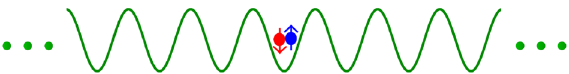
Figure 1. The schematic description of the initial states given in Eq. (5).